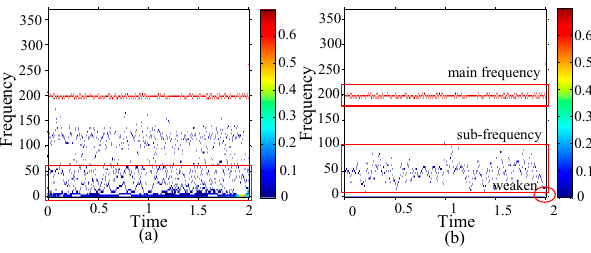
Figure 19. One 0.5mm hole on outer race ( a ) HHT ( b ) GEMD-HHT spectrum.